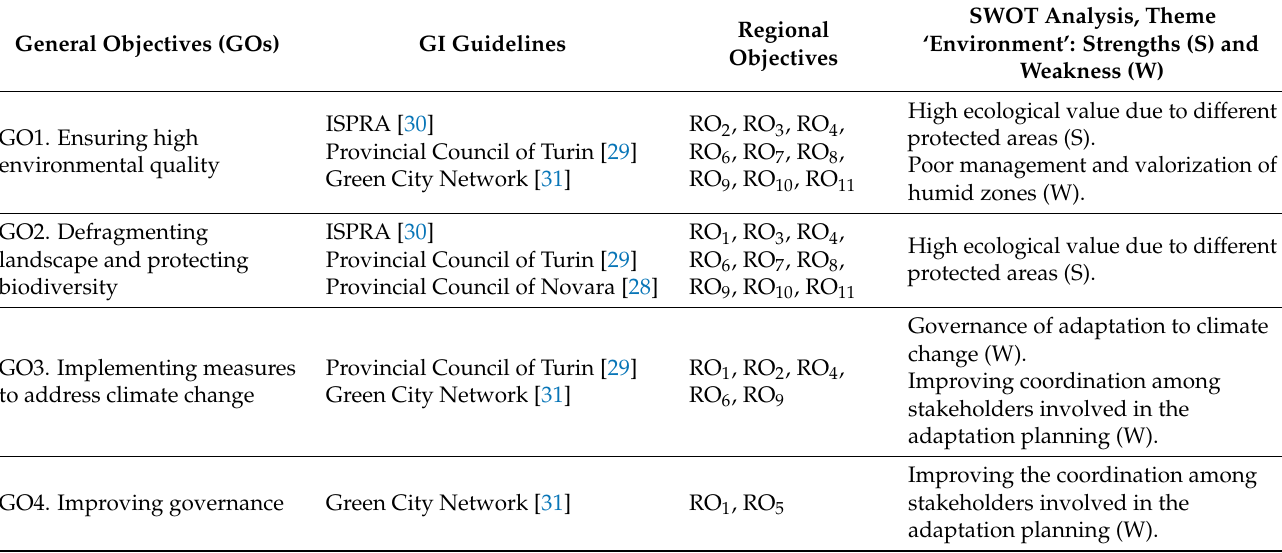
Table 6. General Objectives (GOs) and GI guidelines by regional objectives and SWOT analysis. The regional objectives (ROs) are consistent with the 2030 Agenda, the European Biodiversity Strategy for 2030, and the National Strategy for Sustainable Development.